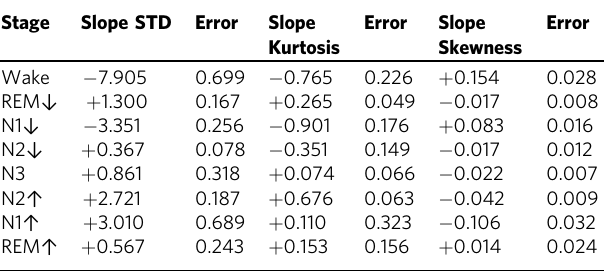
Average slope of hyper-parameters (computed from linear fi ts) in different sleep stages. The stages REM, N1, and N2 have been separately evaluated for the falling ( ↓ ) and rising ( ↑ ) phases of the sleep cycle. Some hyper-parameters have clear trends, with either a positive or negative sign, depending on the sleep